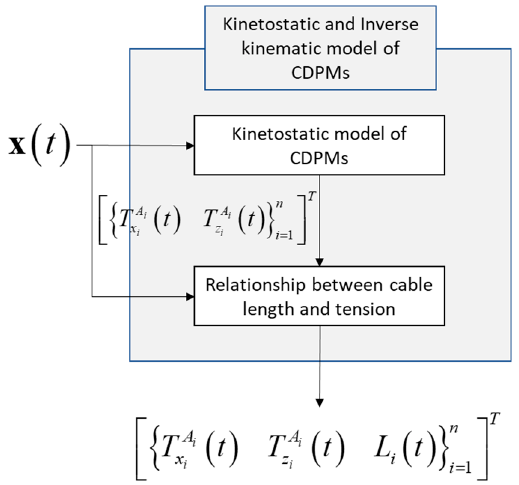
Figure 16. The proposed method used to obtain (17) based on given motion of end-effector.